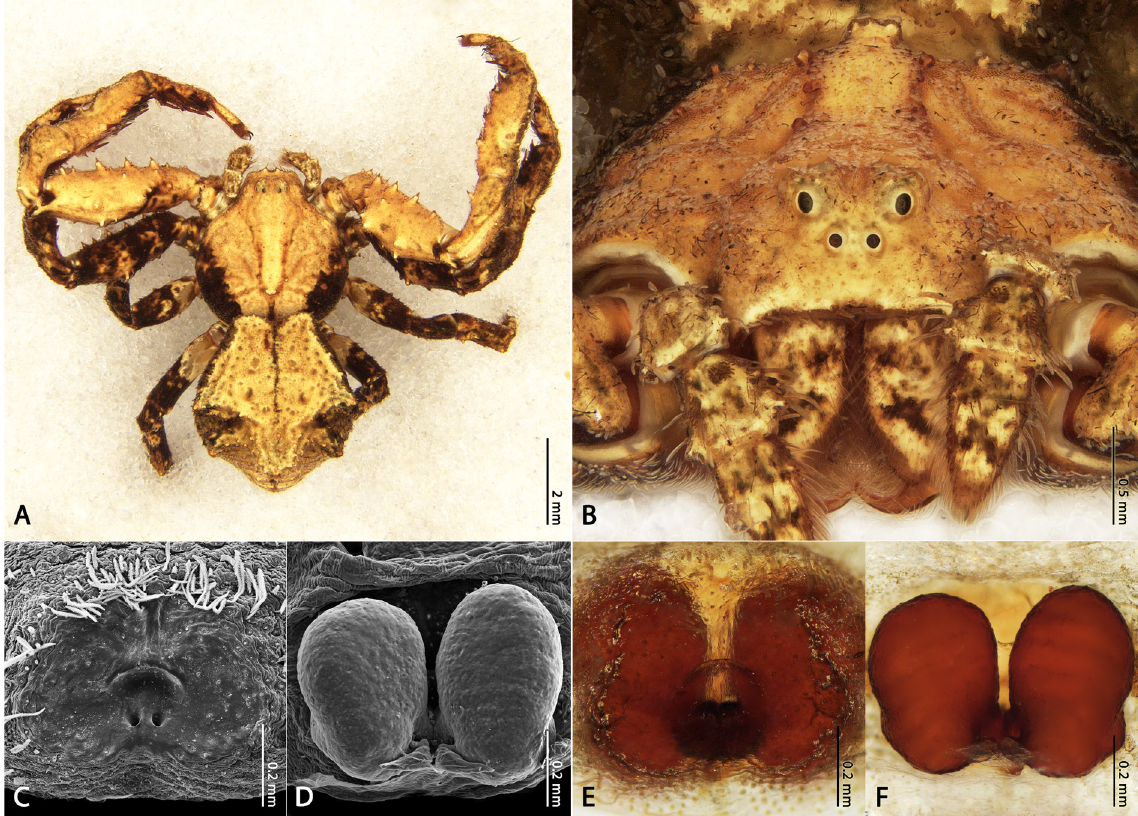
Fig. 12. Female of Kryptochroma quadrata Machado & Viecelli gen. et sp. nov., paratype (MPEG 13297). A . Habitus, dorsal view. B . Front. C, E . Epigynal plate, ventral view. D, F . Spermathecae, dorsal